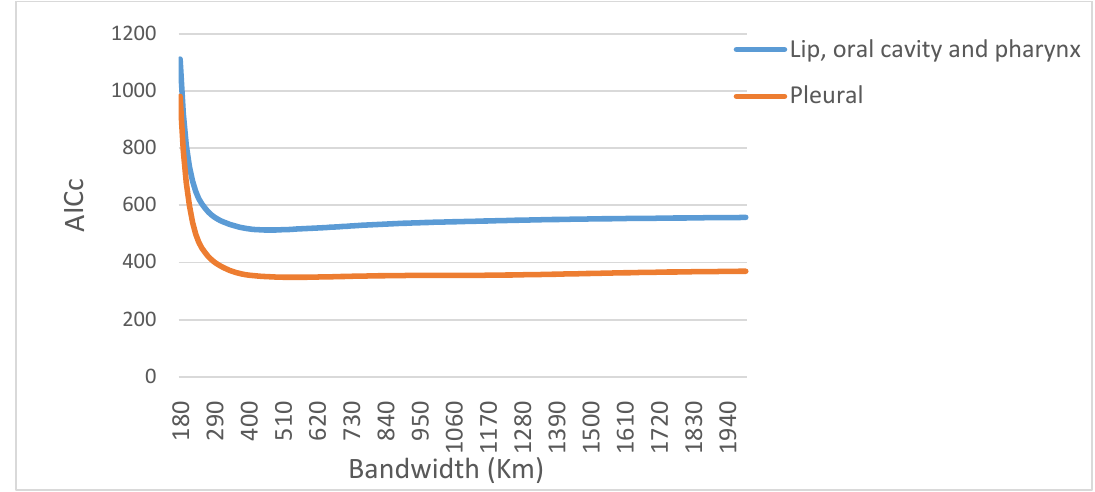
Figure 7. Impact of bandwidth size on the AICc of geographically weighted regression for each